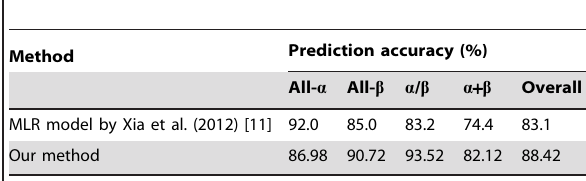
Table 7. Performance comparison of different methods on D8244